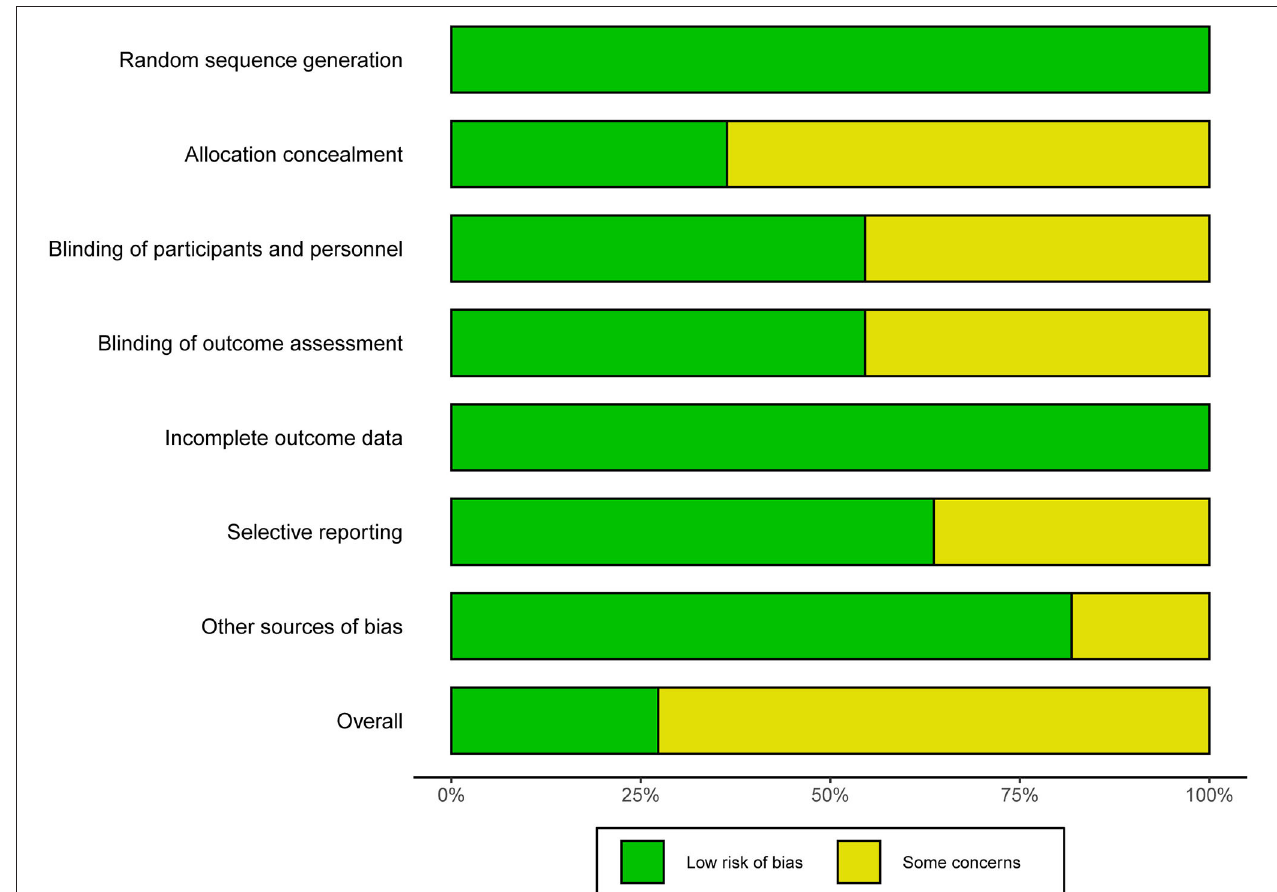
FIGURE 3 | Summary plot of risk of bias.